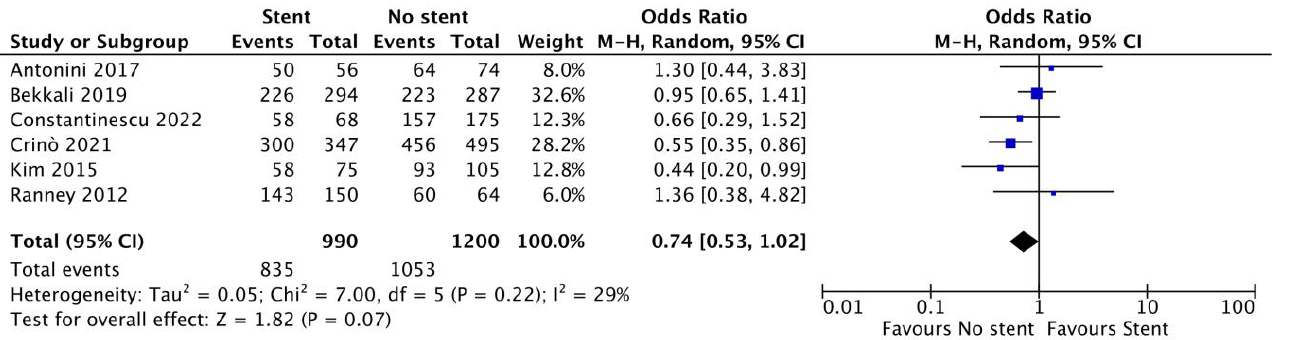
Figure 2. Forest plot — pooled diagnostic accuracy. References [10,11 –